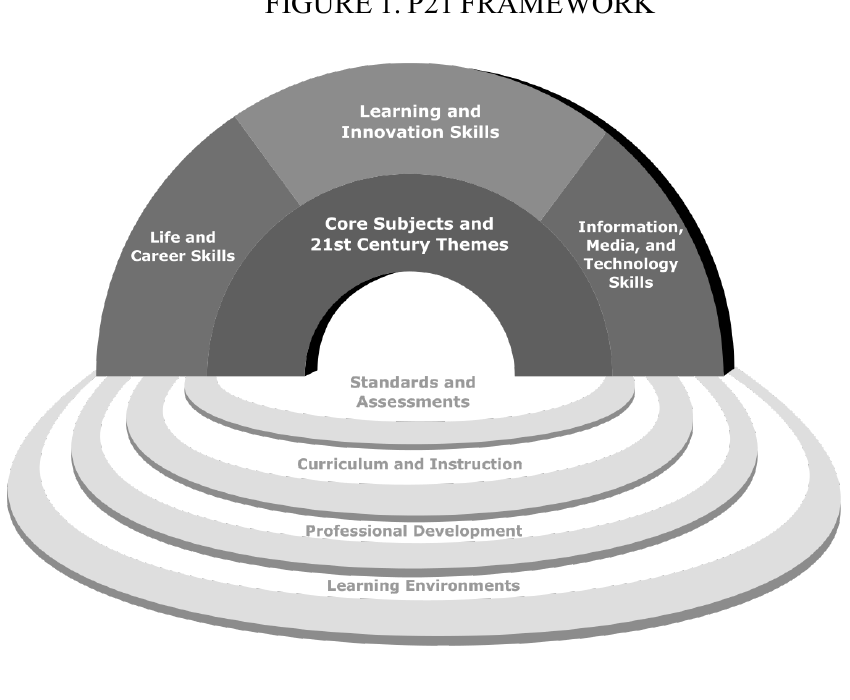
FIGURE 1. P21 FRAMEWORK